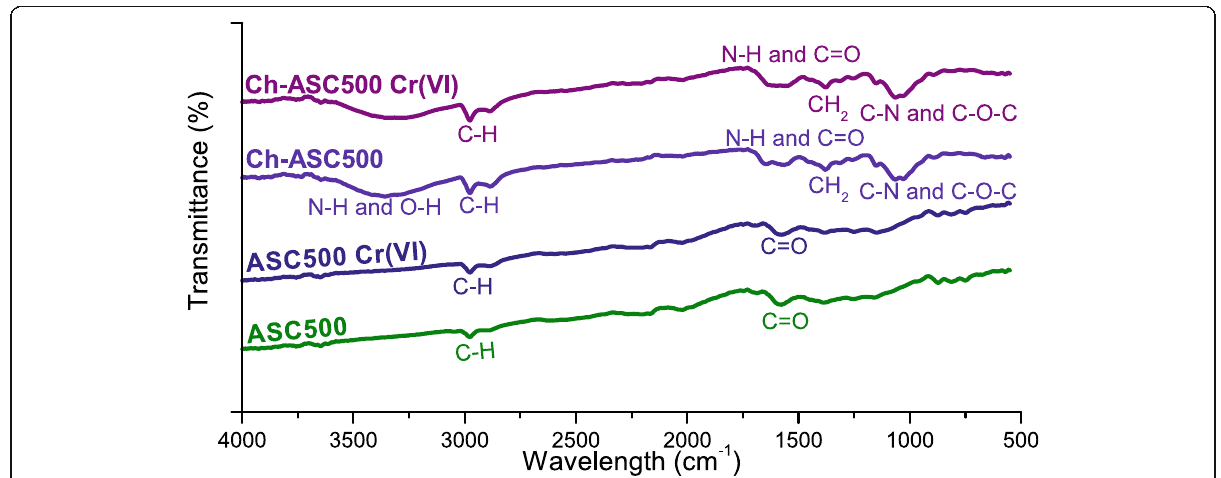
Fig. 2 FTIR spectra of ASC500 and Ch-ASC500 before and after Cr(VI)